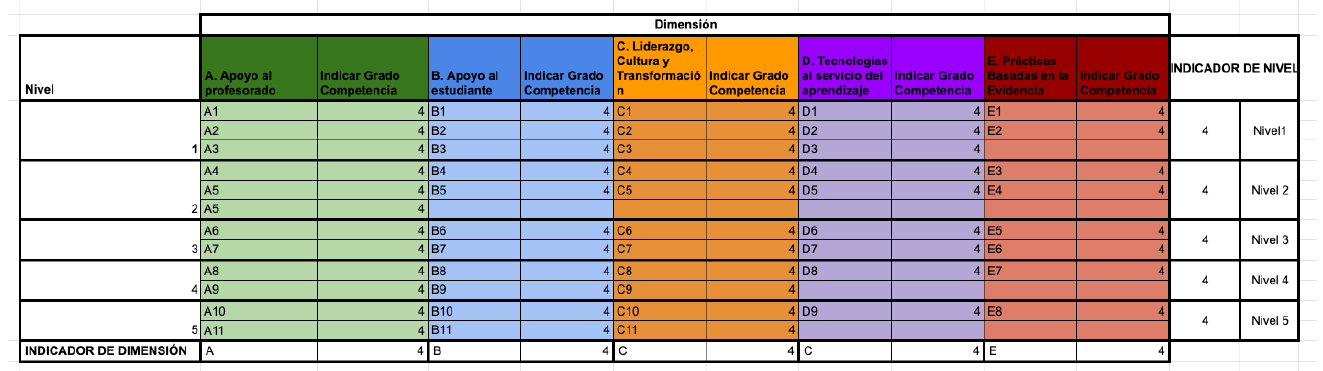
Figure A1. Picture of the calculation of indicators for an institution where all values of competencies, by level and dimension, is maximum (grade 4).